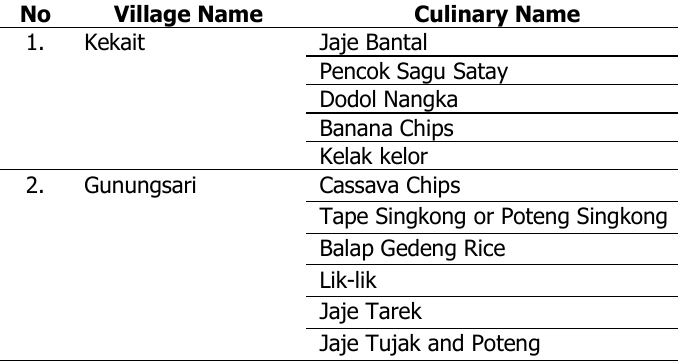
Table 1. Identification of Local Culinary in Gunungsari